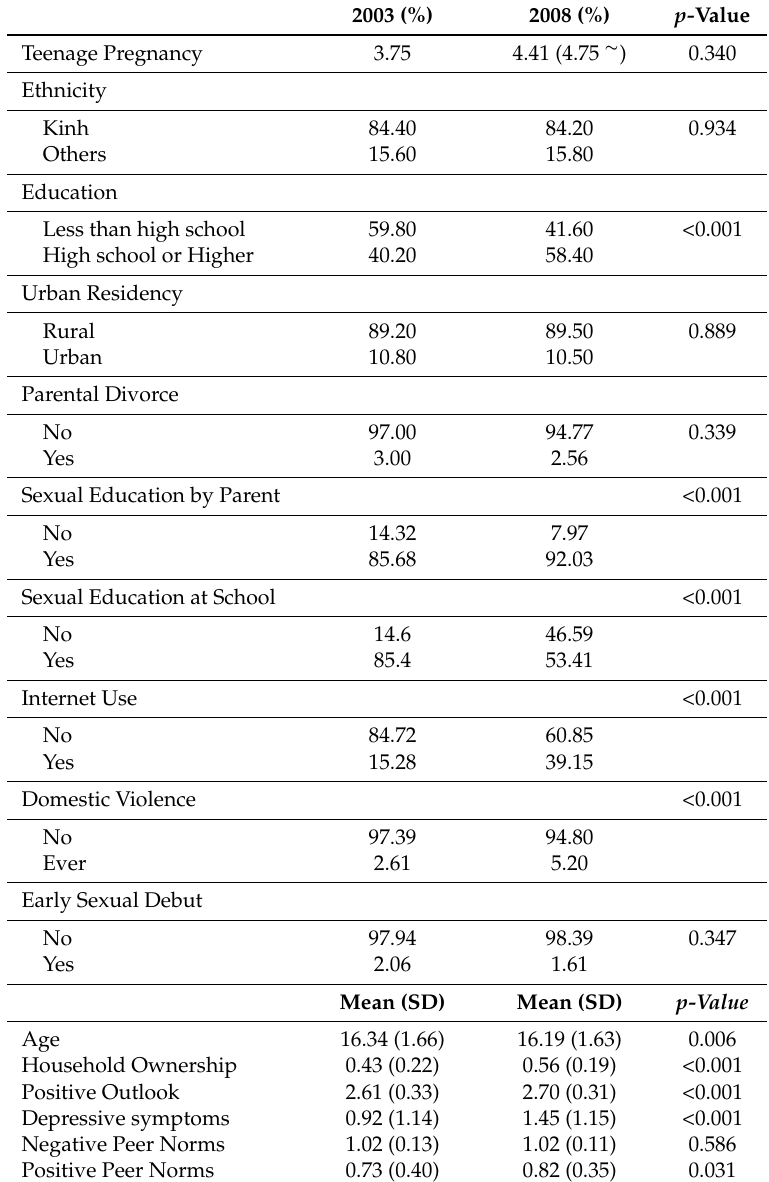
Table 1. Demographic descriptions of Vietnamese teenage girls across two cohorts (2003 vs. 2008).